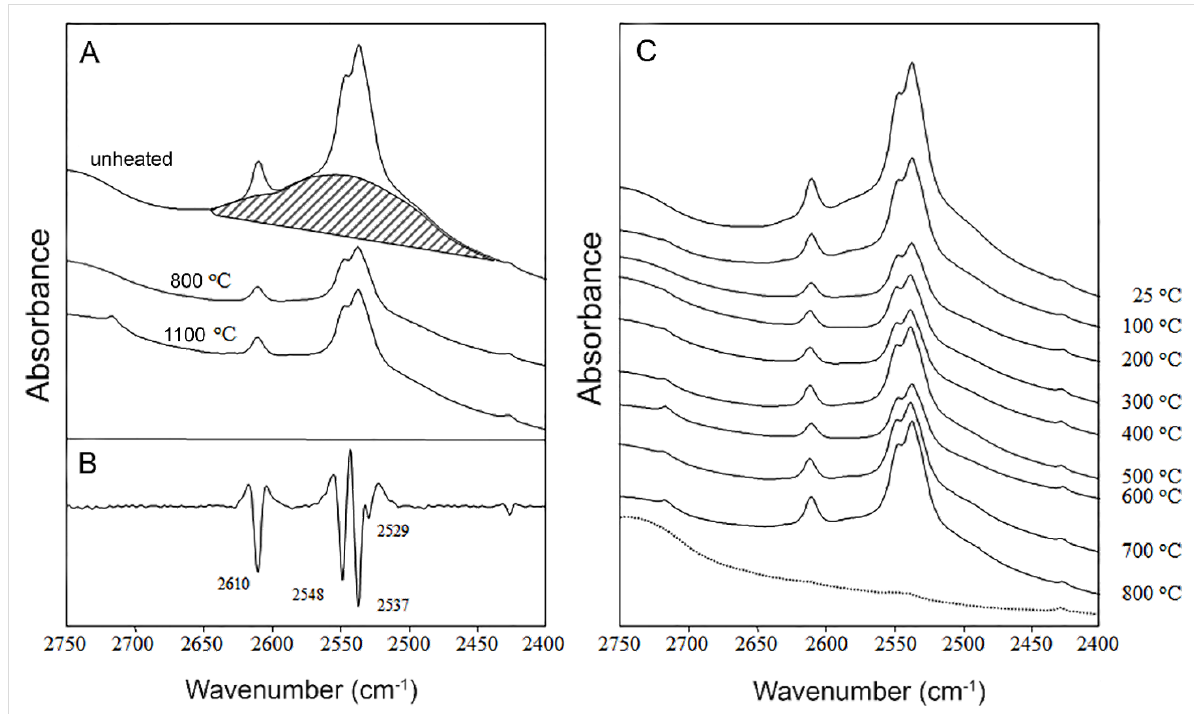
Figure 4: The –OD spectral band in ZrO 2 samples synthesized in the presence of D 2 O. (A) The stretching vibrations of the –OD groups in the ZrO 2 samples synthesized in the presence of D 2 O and annealed at 800 °C or 1100 °C. (B) The corresponding second derivative of the spectrum. (C) The temperature dependence of the –OD band. The dotted line represents the spectrum of ZrO 2 powder obtained in the absence of D 2 O, which therefore lacks –OD stretching